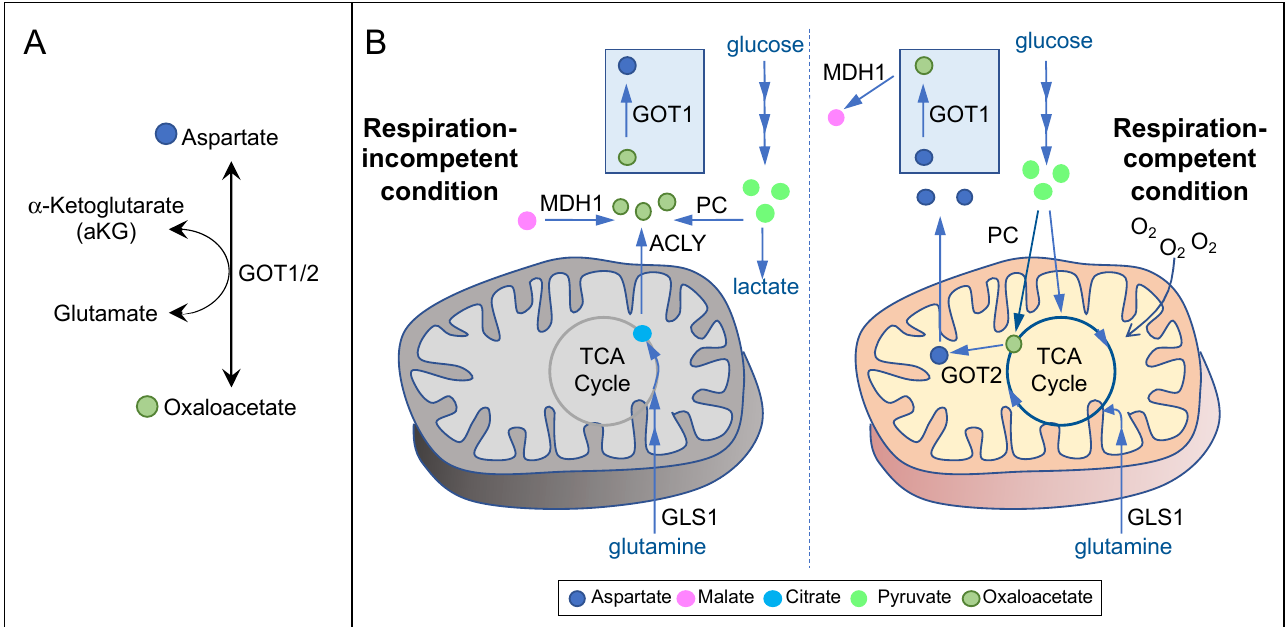
Figure 2. Aspartate biosynthetic pathways under different cell states. ( A ) Aspartate can be produced by glutamic-oxaloacetic transaminase (GOT) 1 or 2, which carries out the reversible reactions from oxaloacetate and glutamate to aspartate and alpha-ketoglutarate. ( B ) Aspartate biosynthetic pathways are determined by cell state, i.e., cell respiration and mitochondrial metabolism. The diagrams depict the enzymes and intermediates (shown by colored dots) involved in aspartate biosynthesis under respiration-competent (right panel) and respiration-incompetent (left panel) conditions. ACLY, ATP-citrate lyase; GOT1 or 2, glutamic-oxaloacetic transaminase 1 or 2; GLS1, glutaminase 1; MDH1, malate dehydrogenase 1; PC, pyruvate carboxylase.